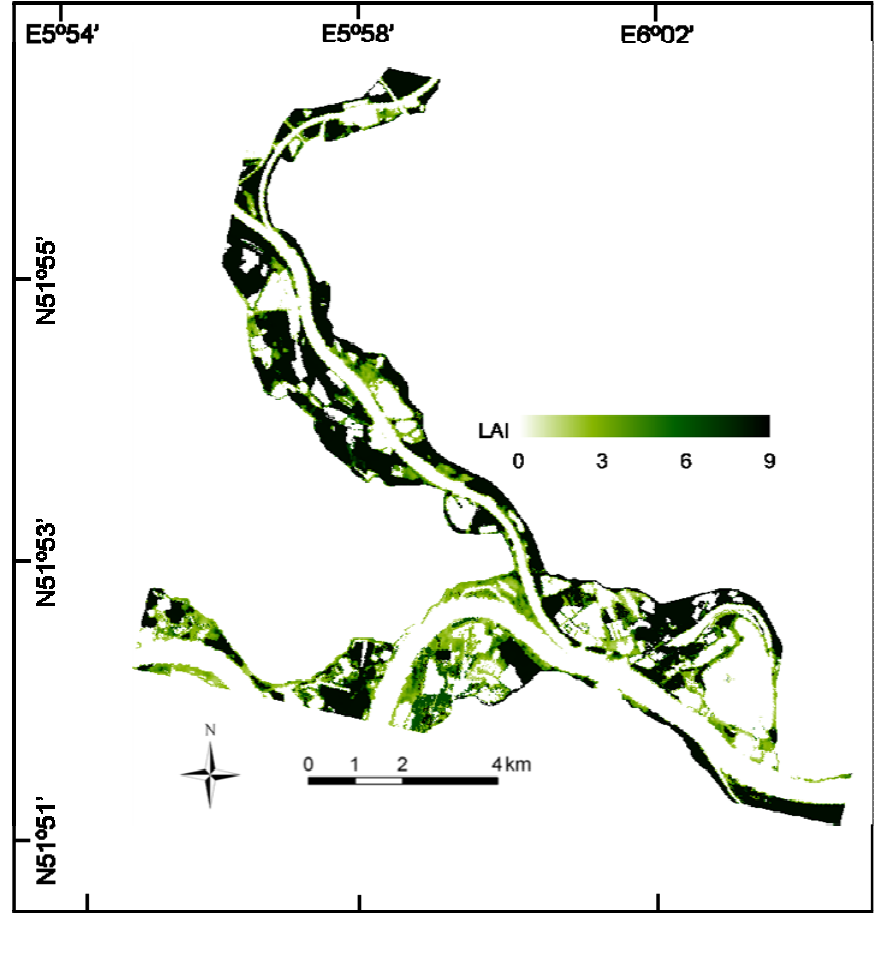
Figure 7. LAI map and histogram for the backward scattering direction ( − 36° VZA), derived with FLIGHT model inversion after applying to the Gelderse Poort